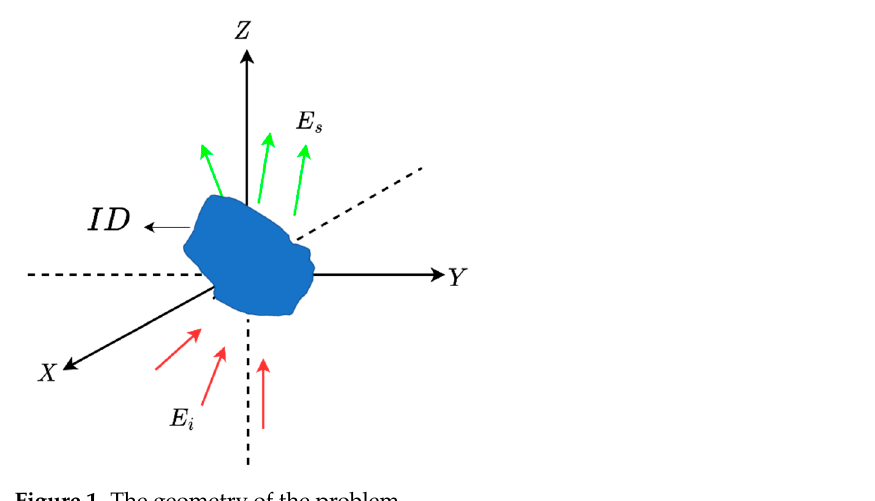
Figure 1. The geometry of the problem.